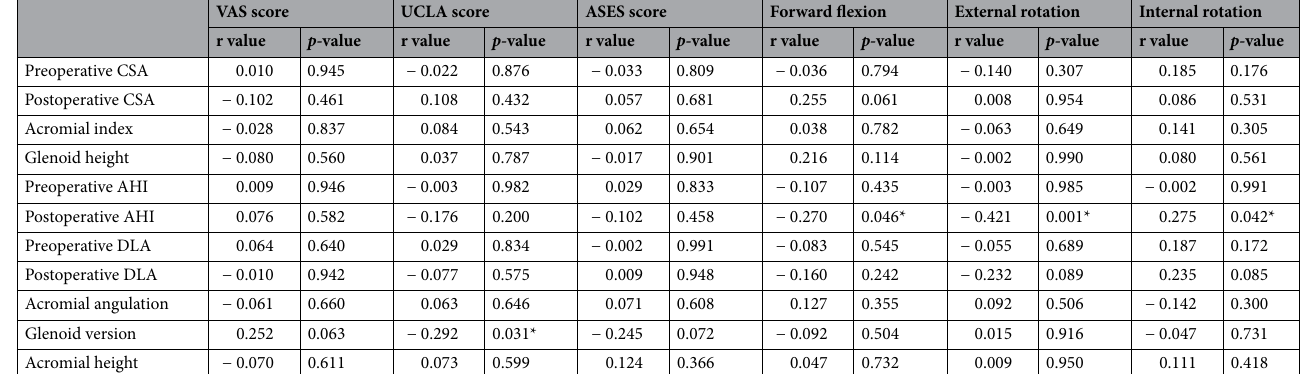
Table 5. Correlations and p -values of all radiographic measurements and final clinical outcomes. VAS visual analog scale, UCLA University of California at Los Angeles, ASES American shoulder and elbow surgeon, CSA critical shoulder angle, AHI acromiohumeral interval, DLA deltoid lever arm. *Statistical significance.